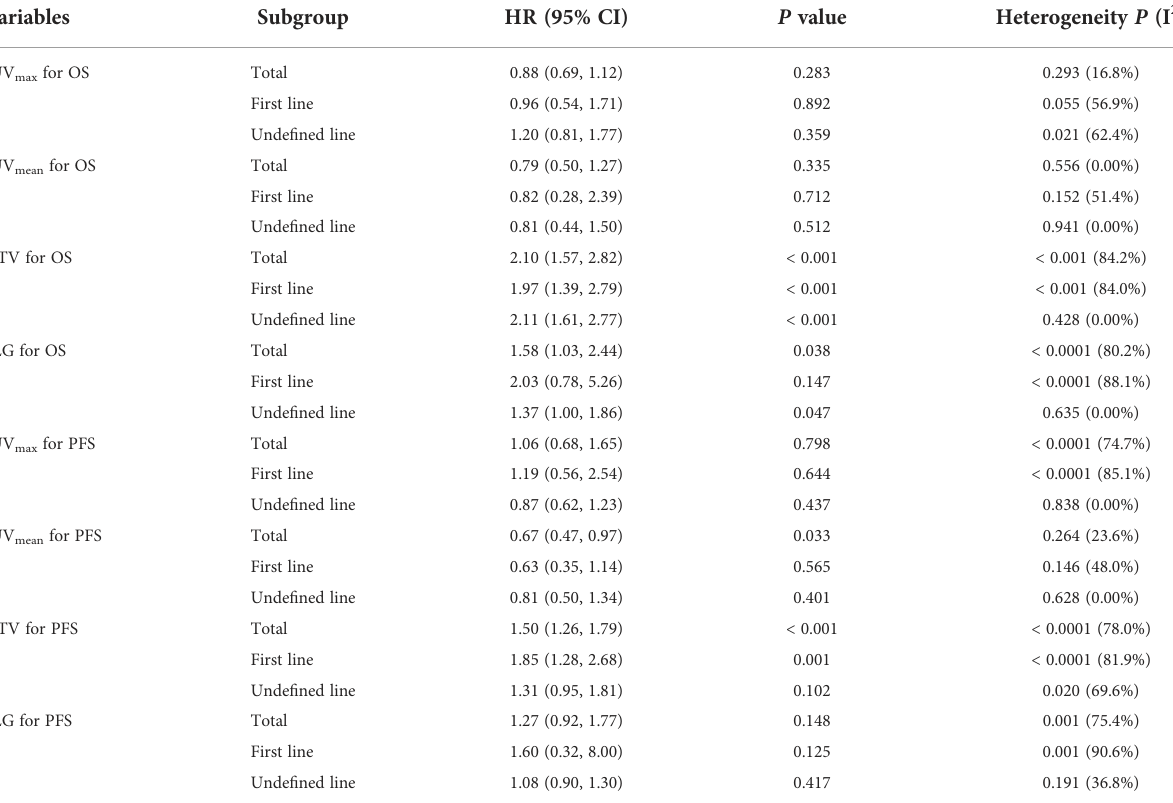
TABLE 3 Subgroup analysis of treatment line for OS and